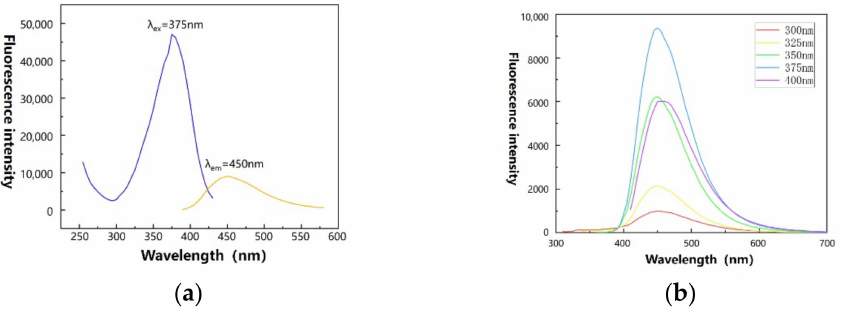
Figure 7. Fluorescence spectrum of CQDs. ( a ) Optimal fluorescence excitation spectrum and fluo- rescence emission spectrum; ( b ) Fluorescence emission spectra at different excitation wavelengths (300–400